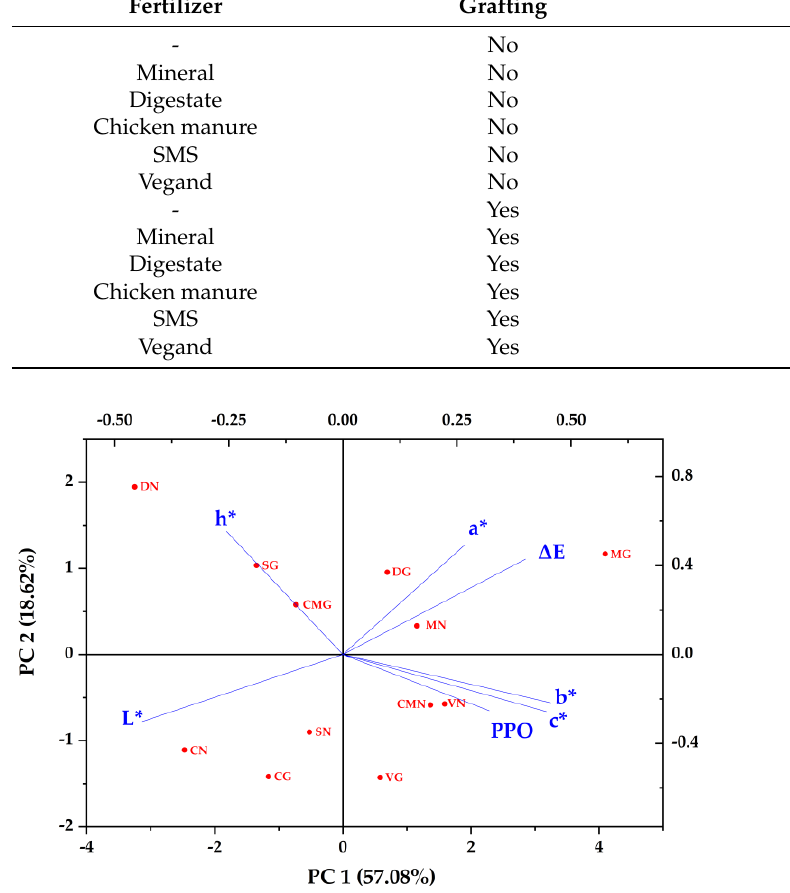
Table 3. Code of samples used on principal components analysis (PCA). Figure 4. ( a ) The total color difference ( ΔE ) of samples comparing to time 0 min; ( b ) the browning index (BI) of samples; ( c ) the pictures of the samples in different times. Results are indicated as mean ± SD ( n = 3). Different small letters indicate a significant difference ( p ≤ 0.05, one-way ANOVA, Tukey’s HSD test ).